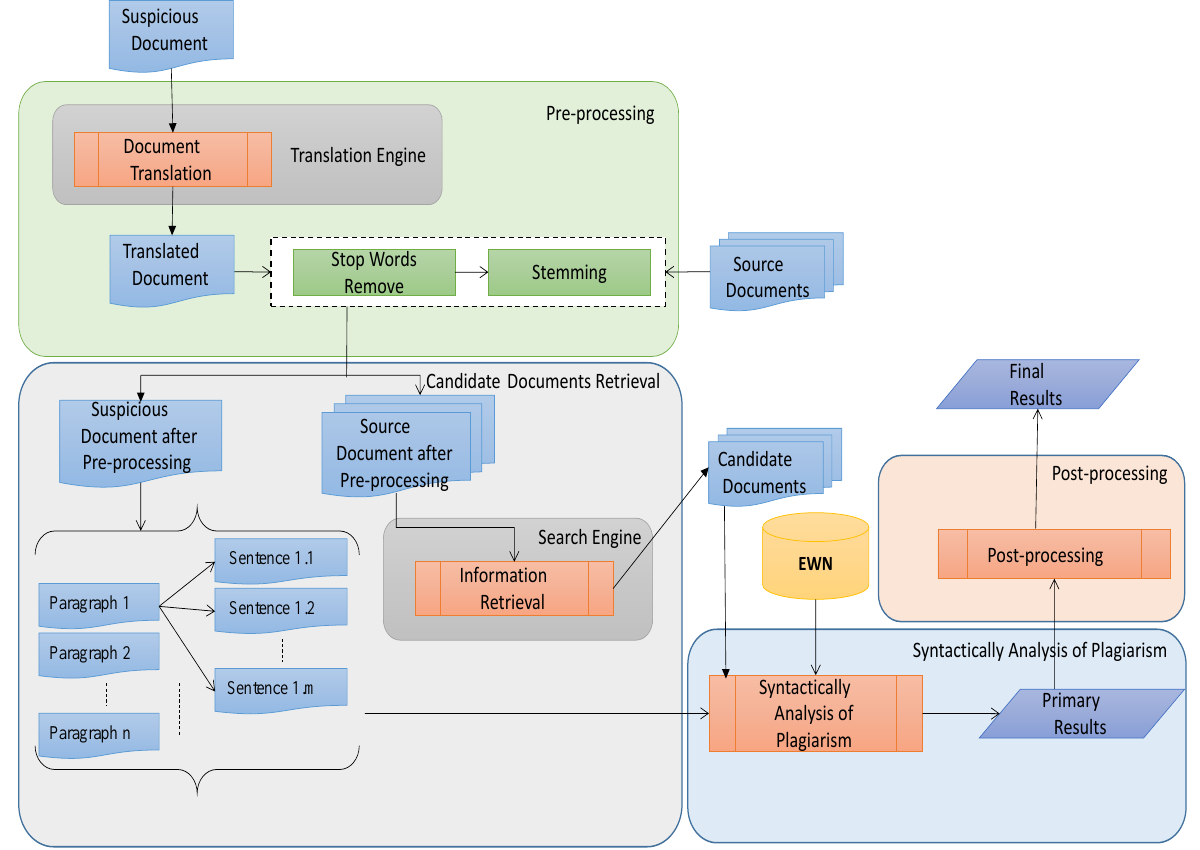
Figure 5. Recommended Framework-